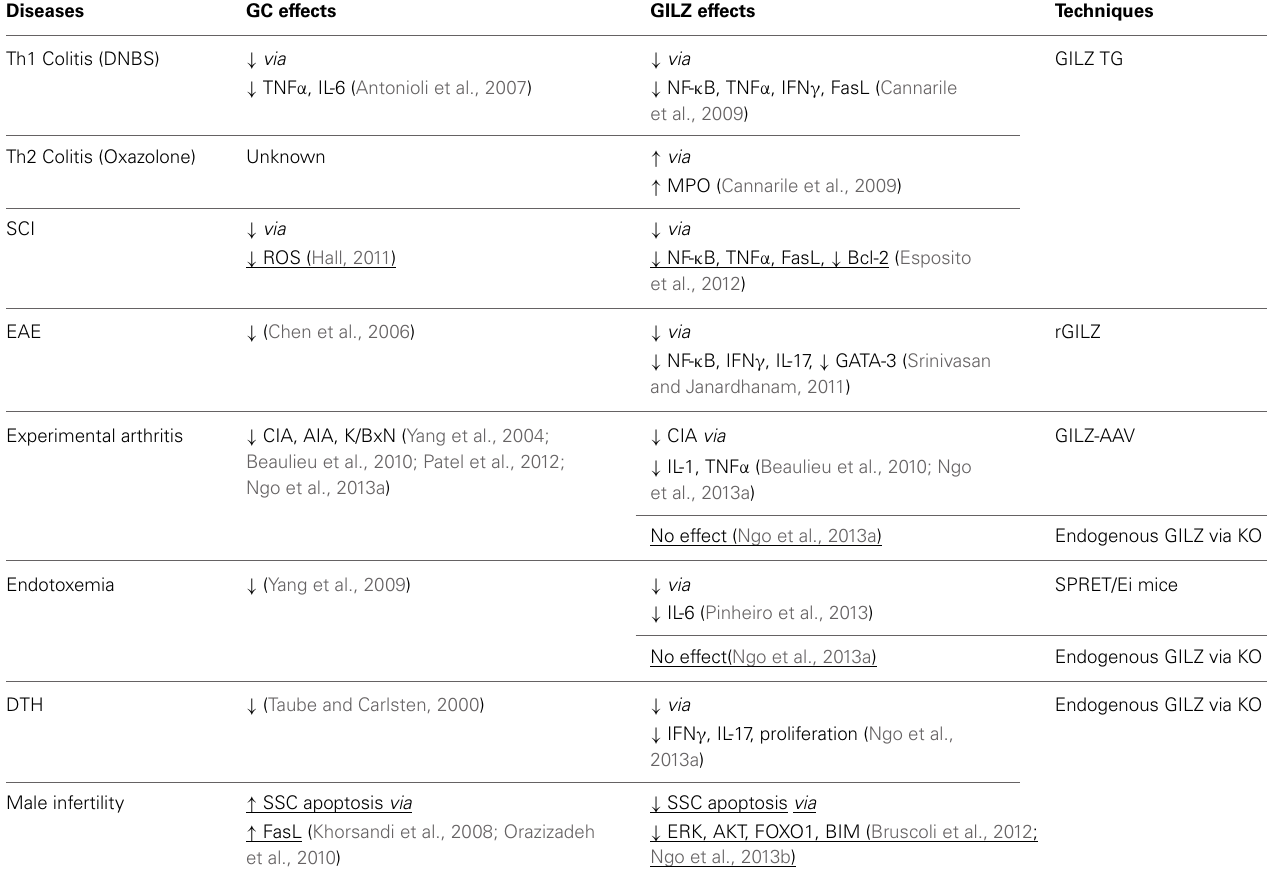
Table 2 | Comparison of GILZ and GC in vivo effects on animal models of